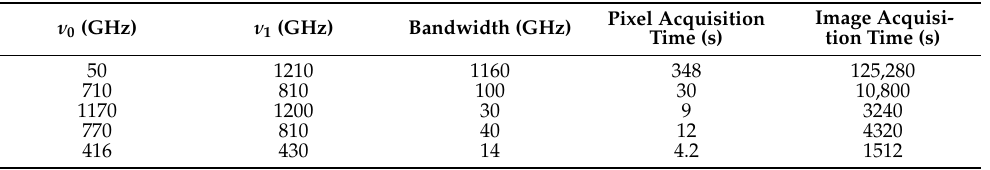
Figure 15. Spectrograms and images for acquisition in the frequency range 1170–1200 GHz: ( a ) Peak envelope spectrogram, ( b ) Unwrapped phase spectrogram. ( c ) Peak envelope spectrogram processed using GSF. ( d ) Unwrapped phase spectrogram processed using GSF. ( e ) Compressed 1D intensity image with marked plastic plates’ positions. ( f ) Compressed 1D phase image with marked plastic plates’ positions. Table 3. Estimated image acquisition times for frequency ranges from Table 2 and for the refer- ence